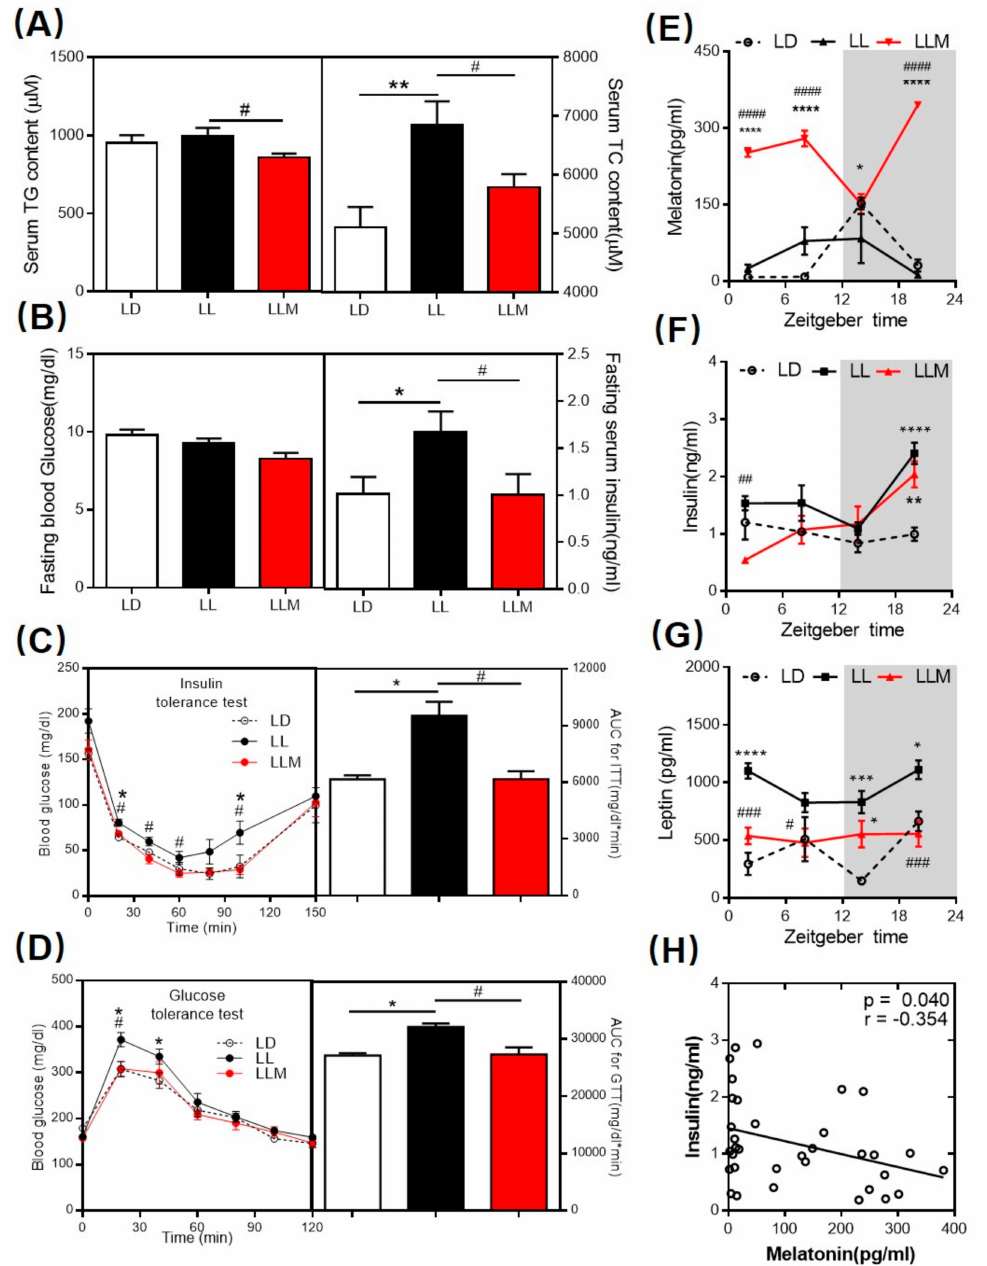
Figure 2. Supplementation of the melatonin level in the nocturnal phase can decrease serum lipid content and ameliorate insulin resistance in HFD-fed mice with constant light. ( A ) Serum triglyceride (TG) and total cholesterol (TC) content. ( B ) Fasting blood glucose and serum insulin levels. ( C ) Insulin tolerance test (ITT) and ( D ) glucose tolerance test (GTT) results. ( E ) Serum melatonin levels, ( F ) serum insulin levels and ( G ) serum leptin levels in mice after 24 h. ( H ) Correlations are depicted between the serum melatonin level and insulin level. Values are presented as the mean ± SEM. * p < 0.05; ** p < 0.01; *** p < 0.001; **** p < 0.0001 compared with LD, # p < 0.05; ## p < 0.01; ### p < 0.001; #### p < 0.0001 compared with LL by one-way ANOVA ( A – D , n = 16–20) and repeated measure (RM) two-way ANOVA ( E – G , n =